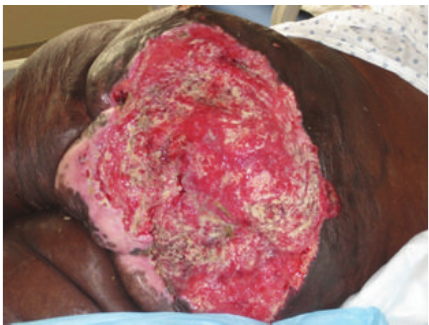
Figure 1: 16 × 27.5 cm friable ulcer with fibrinopurulent exudate and exophytic, granulation tissue centrally and peripherally.